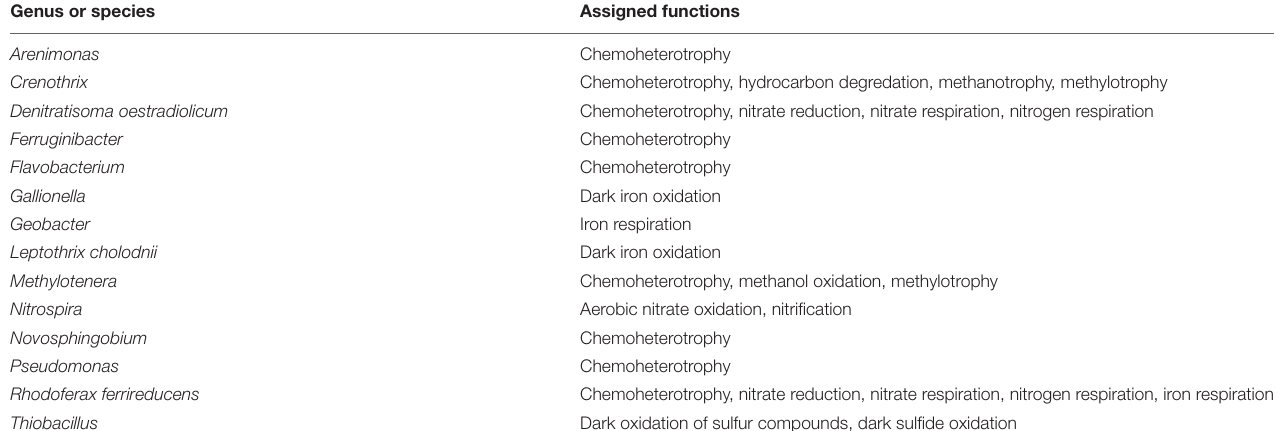
TABLE 2 | Functions assigned to highly abundant genera via FAPROTAX. Genus or species Assigned functions